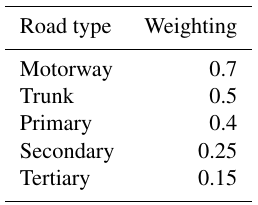
Table 3. Estimated emission weighting factors for each modelled road